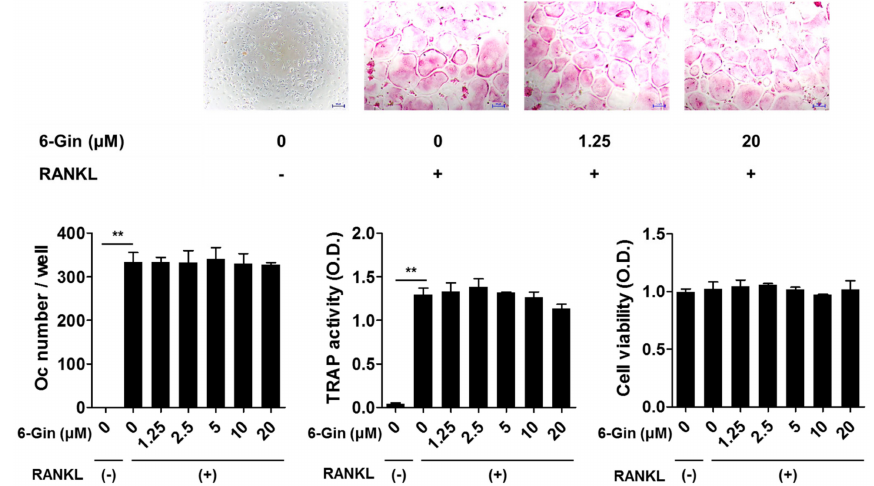
Figure 2. 6-Gingerol does not affect receptor activator of NF- κ B ligand (RANKL)-induced osteoclast formation in bone marrow-derived macrophages (BMMs). BMMs were incubated with or without macrophage colony-stimulating factor (M-CSF) (30 ng/mL), RANKL (100 ng/mL), and 6-gingerol (6-Gin, 1.25–20 µ M) for four days. Total cellular TRAP activity and the number of osteoclasts were measured. Cell viability was determined using Cell Counting Kit-8 assay. ** p < 0.01 vs. control with no RANKL treatment. Scale bar = 100 µ